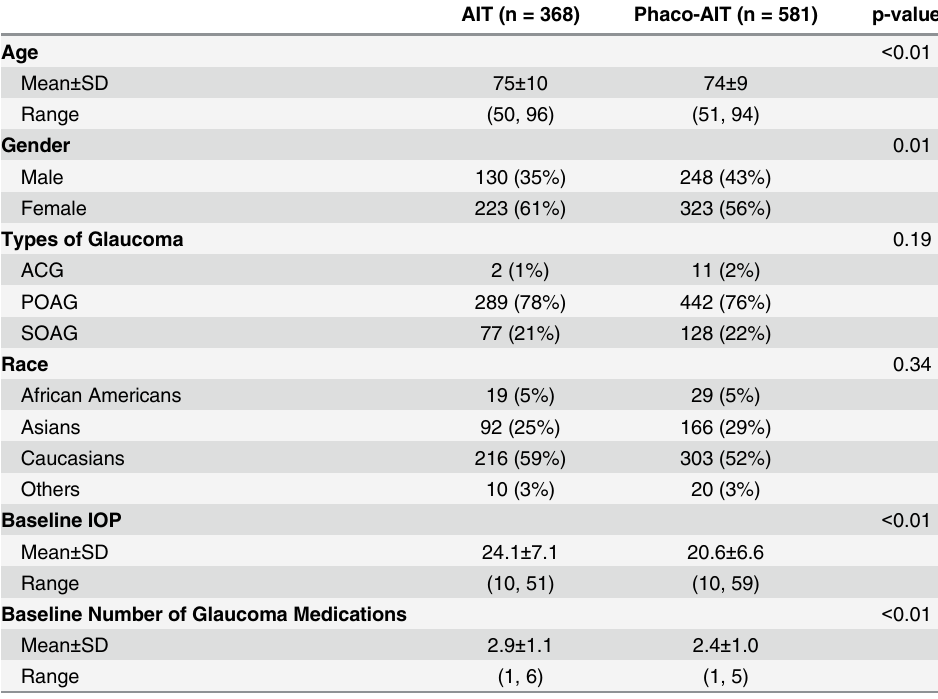
Table 1. Raw data demographics of study population. Demographics for AIT-only and phaco-AIT show significant difference (p < 0.05) for age, gender, baseline IOP, and baseline number of medications in unmatched